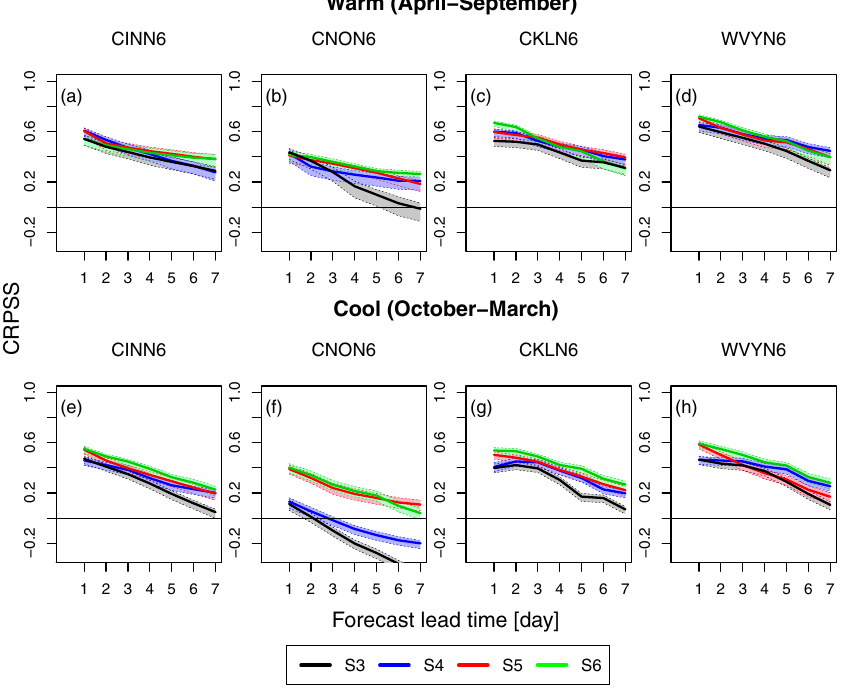
Figure 5. Continuous ranked probability skill score (CRPSS) of the mean ensemble flood forecasts vs. the forecast lead time during the (a) – (d) warm (April–September) and (e) – (h) cool season (October–March) for the selected basins. The curves represent the different fore- casting scenarios S3–S6. Note that S3 consists of GEFSRv2 + HL-RDHM, S4 of GEFSRv2 + HCLR + HL-RDHM, S5 of GEFSRv2 + HL- RDHM + QR, and S6 of GEFSRv2 + HCLR + HL-RDHM +